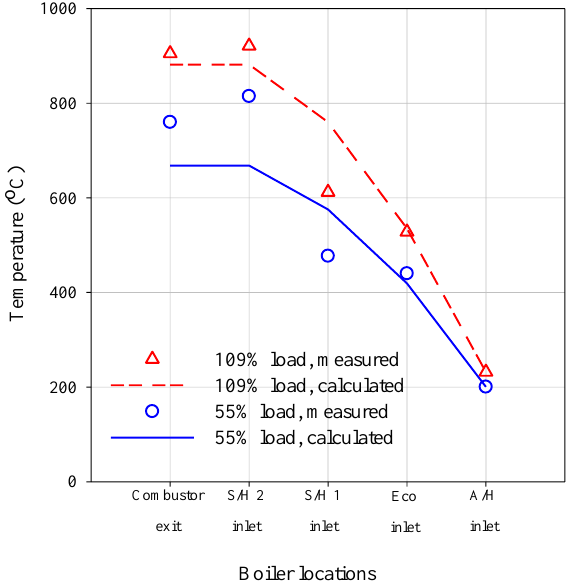
Figure 3. Measured and calculated temperature difference at boiler locations.